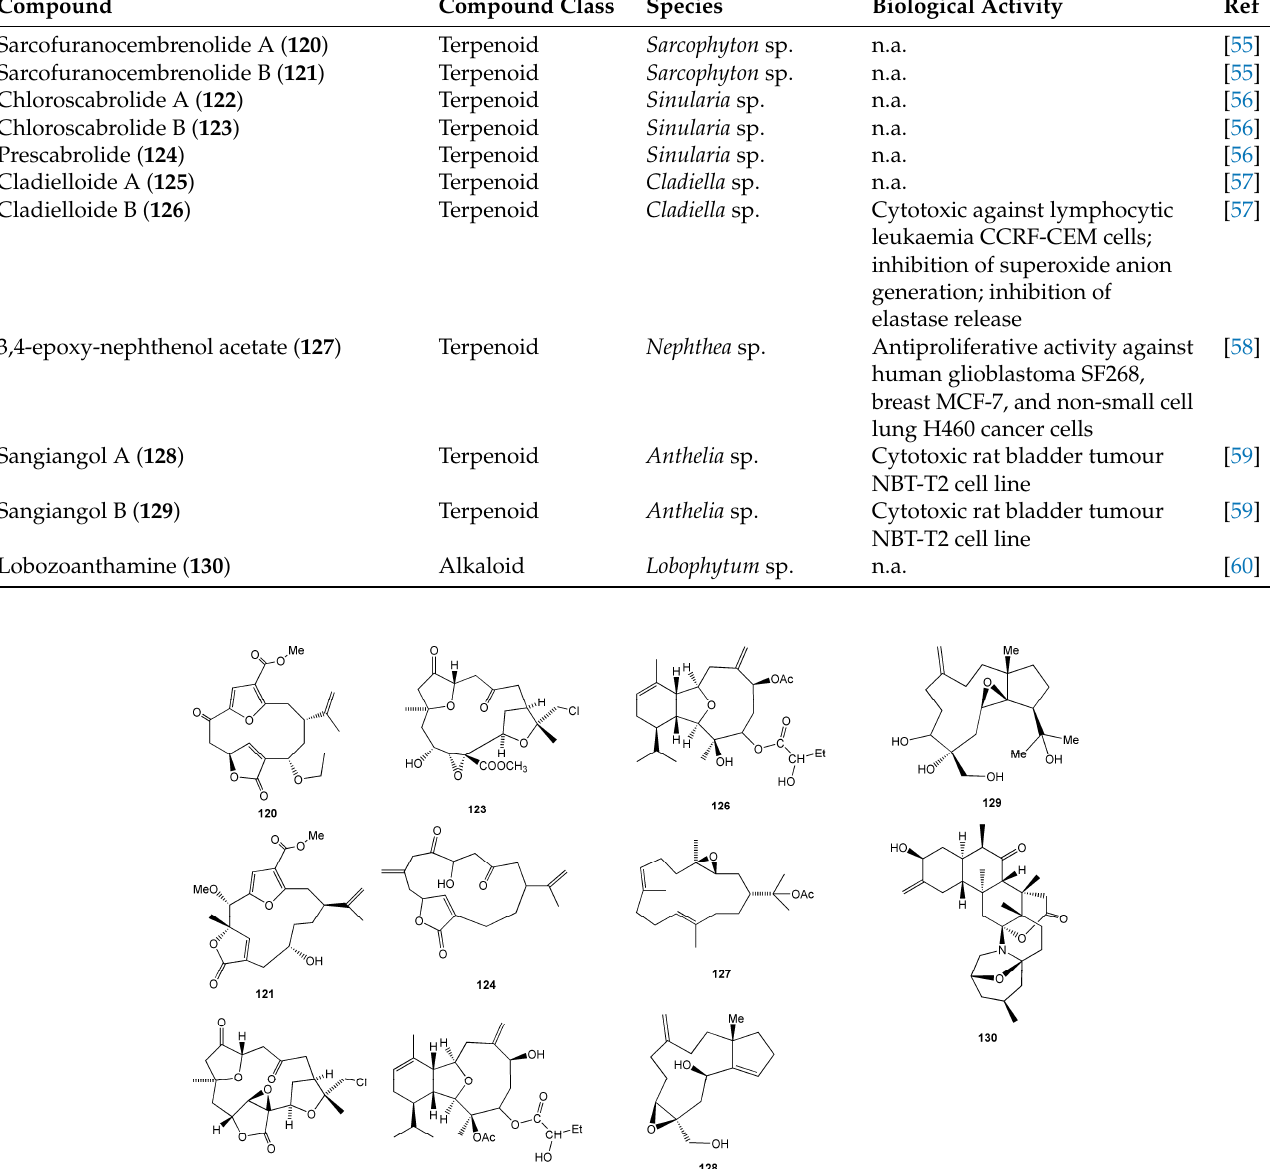
Table 3. Summary of the marine natural products isolated from the marine soft corals from Indonesian oceans.